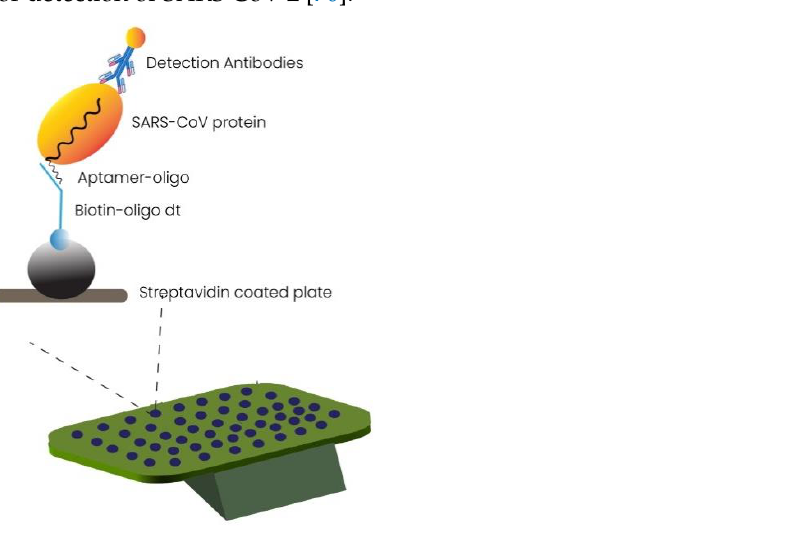
Figure 4. Figure illustrates the detection principle of SARS-CoV protein by aptamer-based technology. The streptavidin-coated plates,further coated with biotin labeled oligo (dT) 16 , are bound to aptamer oligo(A) 16 , which is attached to SARS-CoV N protein from patient sample. The detection antibodies such as polyclonal anti SARS-CoV N protein antibody bind to the N protein of SARS-CoV-2 for making complex and Alkaline phosphatase-conjugated goat anti-rabbit IgG antibody for measuring chemiluminescence.